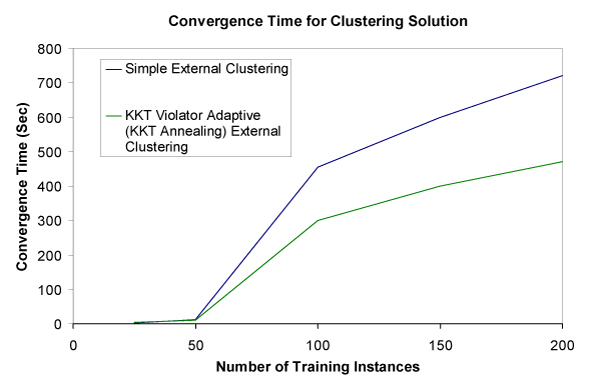
Efforts are underway to use simulated annealing in the number of KKT Violators tolerated on each iteration of the external clustering algorithm, to accelerate the convergence (clustering) process. Our current approach, results shown, approximately halves the cluster time needed.